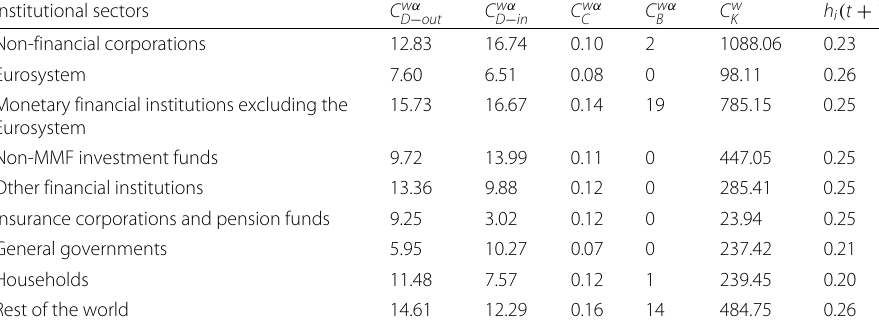
Table 5 Network statistics - multilayer macro-network Institutional